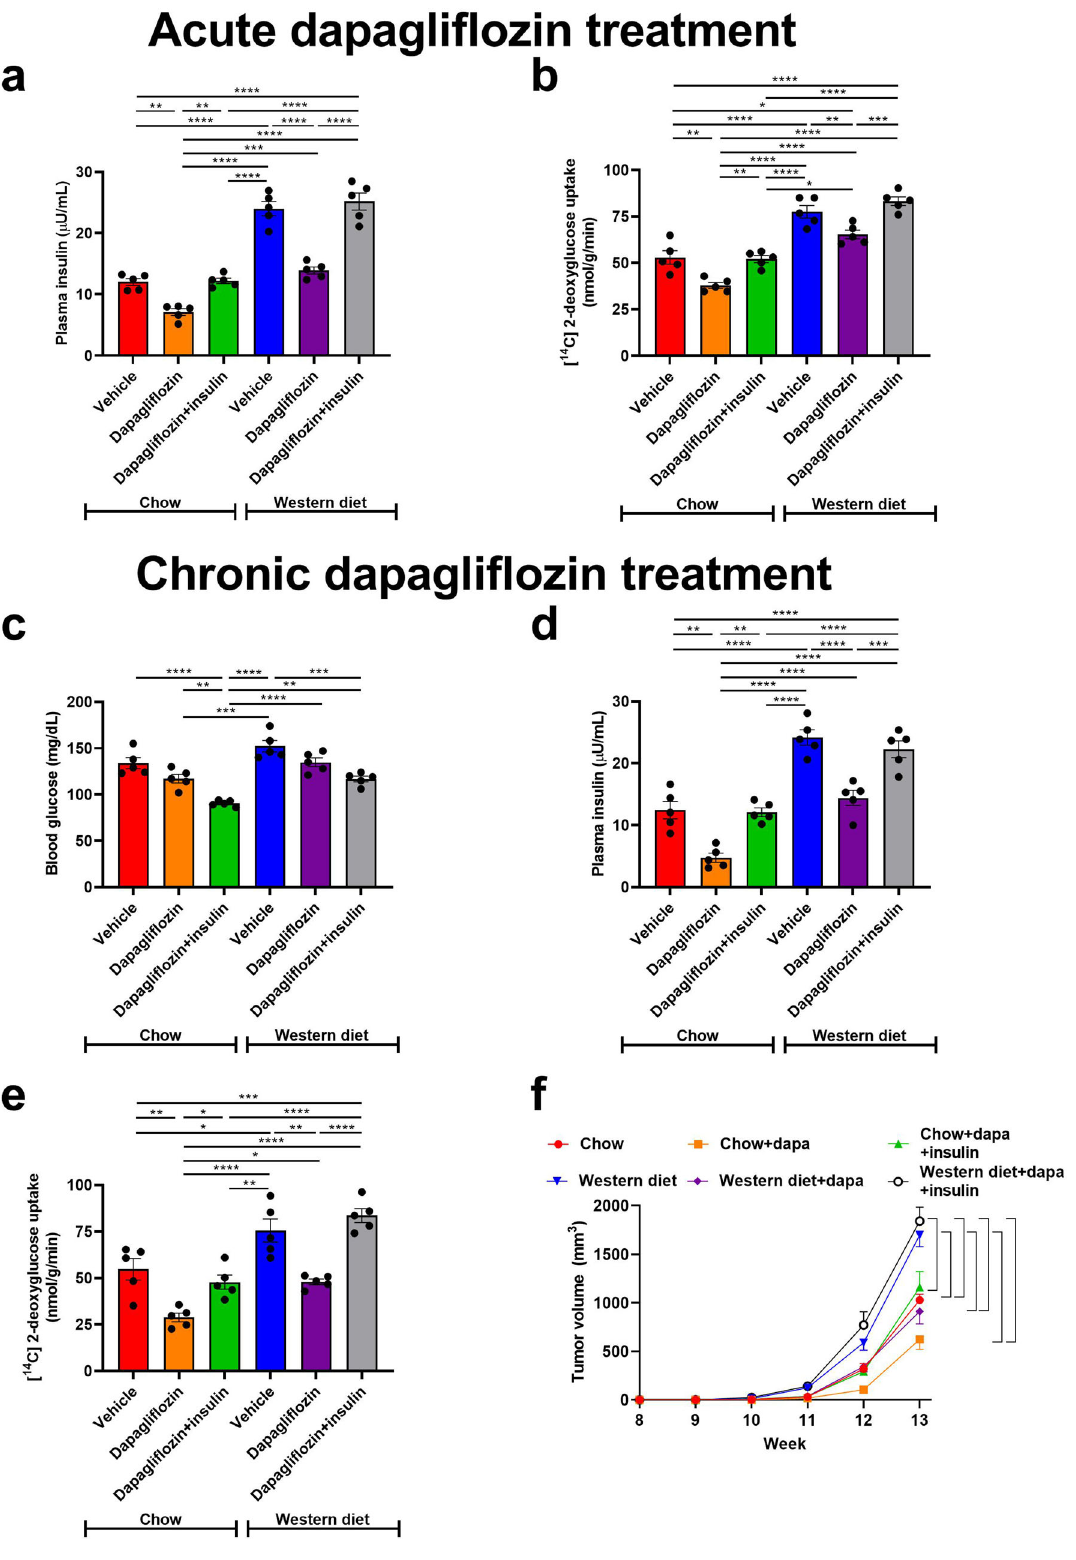
Fig. 2 Dapagli fl ozin slows spontaneous tumor growth in lean and obese MMTV-PyMT mice, correlated with its effect to lower plasma insulin concentrations. a Plasma insulin and ( b ) Tumor [ 14 C] 2-deoxyglucose uptake in mice treated acutely with a single dose of dapagli fl ozin (2.5 mg/kg). c , d Blood glucose and plasma insulin in mice treated continuously for four weeks with dapagli fl ozin in drinking water. e Tumor [ 14 C] 2-deoxyglucose uptake in mice treated chronically with dapagli fl ozin. In panels ( a – e ), mice were studied after a 6 h fast. * P < 0.05, ** P < 0.01, *** P < 0.001, **** P < 0.0001 by ANOVA with Tukey ’ s multiple comparisons test. n = 5 per group. f Tumor growth. The mean ± S.E.M. of n = 5 per group is shown. Brackets denote statistically signi fi cant ( P < 0.05) comparisons by ANOVA with Tukey ’ s multiple comparisons